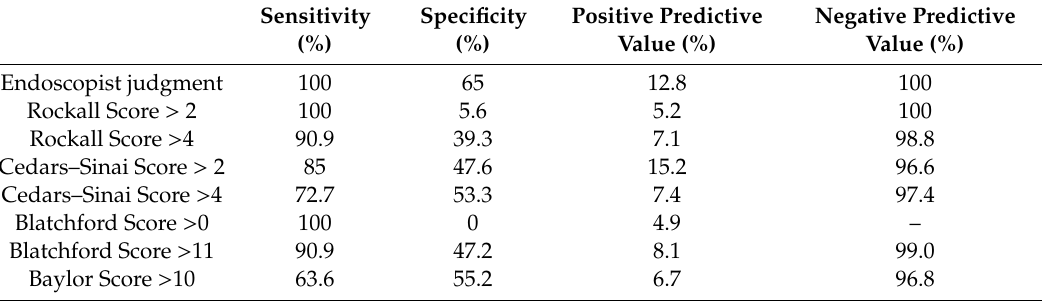
Table 4. Sensitivity, specificity and positive predictive values for mortality (endoscopic treatment